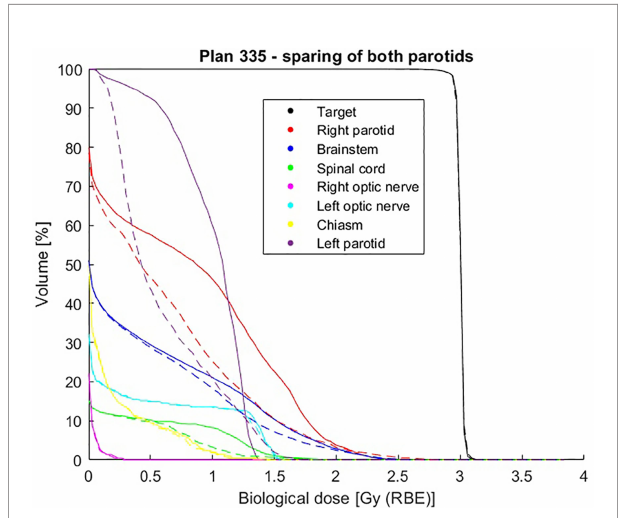
FIGURE 8 | Comparison of dose – volume histograms (DVHs) obtained with voxel-dose-based (solid line) and generalized equivalent uniform dose (gEUD)- based (dashed line) optimization for patient plan 335, considering both parotid